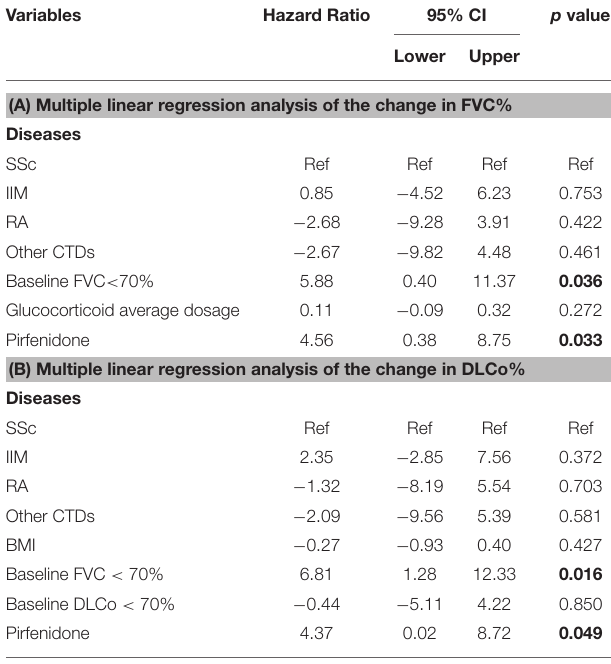
TABLE 4 | Multiple linear regression analysis of the change in PF in patients with CTD-ILD: multiple linear regression analysis of the change (A) in FVC% and (B) in DLCo%.